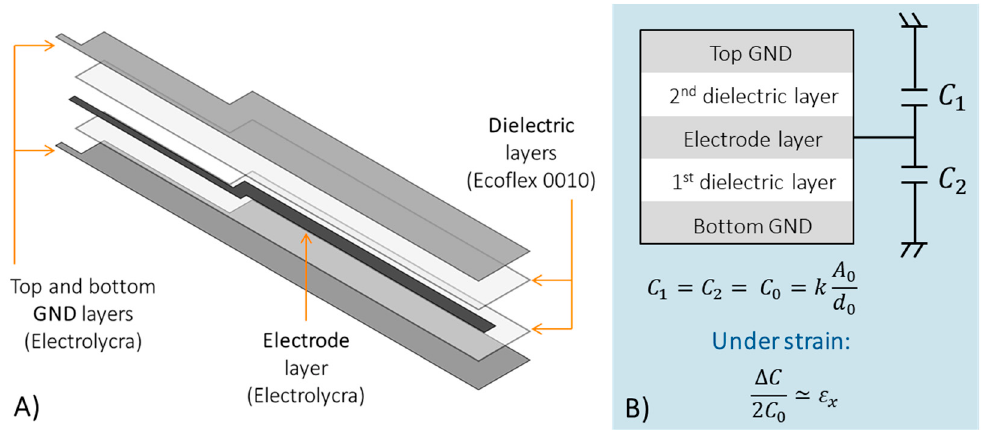
Figure 1. Technological ( A ) and electrical ( B ) scheme of the three-electrode soft sensor configuration.